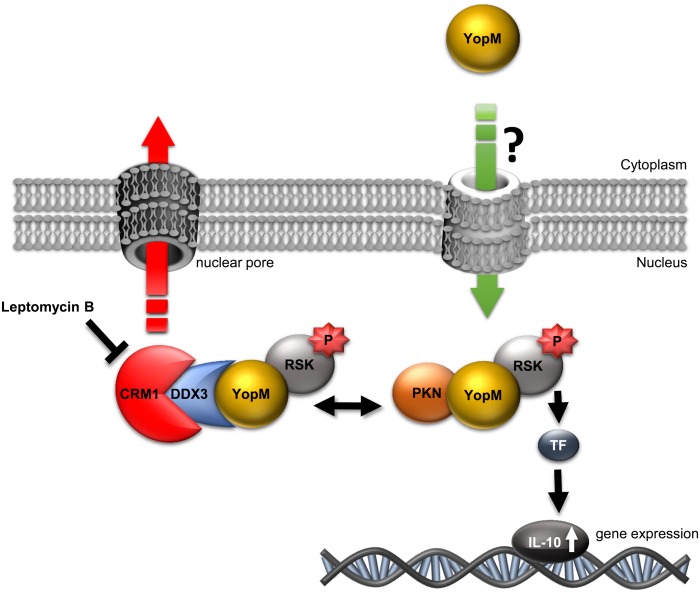
Model of nuclear shuttling and intranuclear activity of YopM.YopM enters the nucleus from the cytoplasm of infected cells through an unknown pathway. In the nucleus YopM forms at least two complexes: YopM:RSK:PKN and YopM:RSK:DDX3. Hyperphosphorylated RSK within the complex induces IL-10 expression. DDX3 mediates nuclear export of YopM via the LMB-sensitive CRM1 export pathway. Abbreviations: RSK, Ribosomal S6 kinase; PKN, Protein kinase N; DDX3, DEAD box helicase 3; CRM1, chromosome region maintenance 1; P, phosphate group; TF, transcription factor.